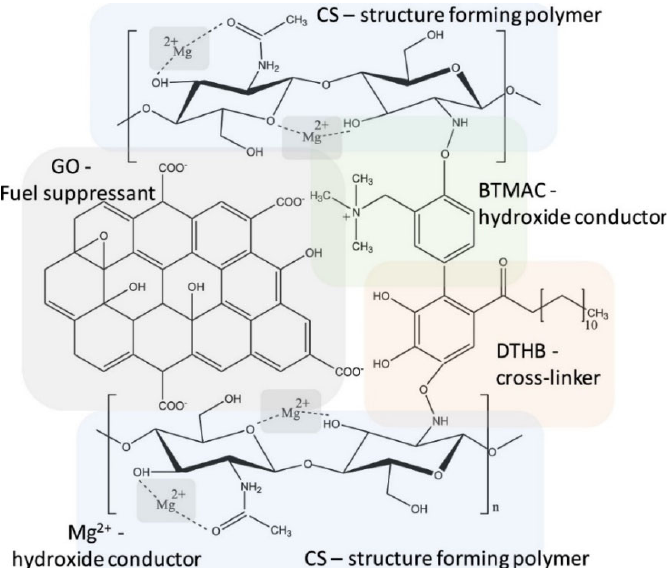
Figure 5. Proposed structure of the CS ‐ Mg ‐ GO ‐ BTMAC ‐ DTHB membrane and designated role of individual components. Reprinted with permission from Ref. [32]. Copyright 2019 American Chem ‐